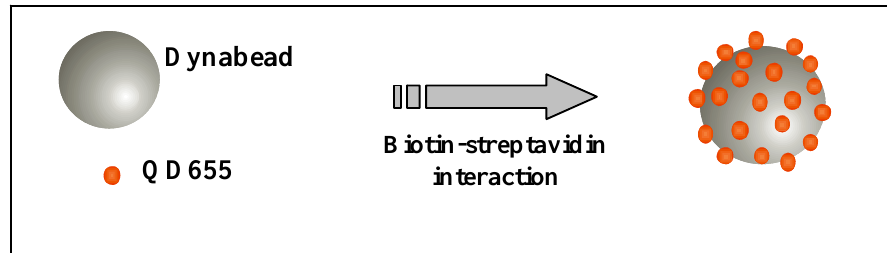
Figure 1. Schematic representation of Dynabeads labelled with QD655 by the biotin- streptavidin